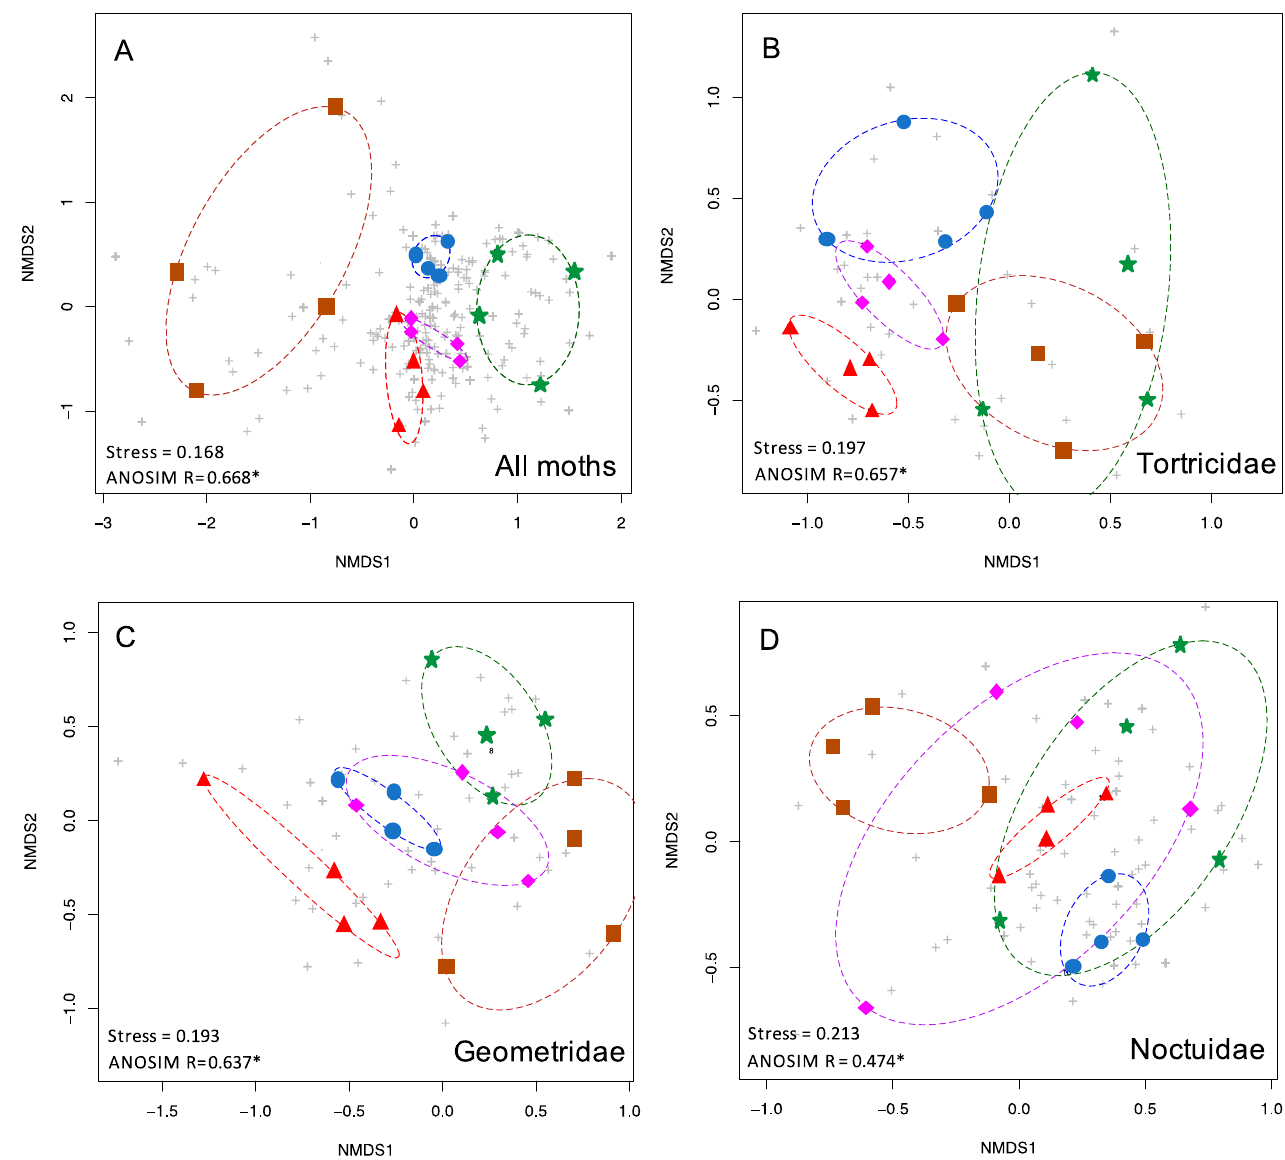
Figure 2. nMDS plots showing the two-dimensional ordination for moth communities in five habitat types. Colored symbols are as in Figure 1. Grey pluses indicate individual species. Shown here are ( A ) the complete moth community (510 spp), ( B ) Tortricidae (54 spp), ( C ) Geometridae (56 spp), and ( D ) Noctuidae (124 spp).